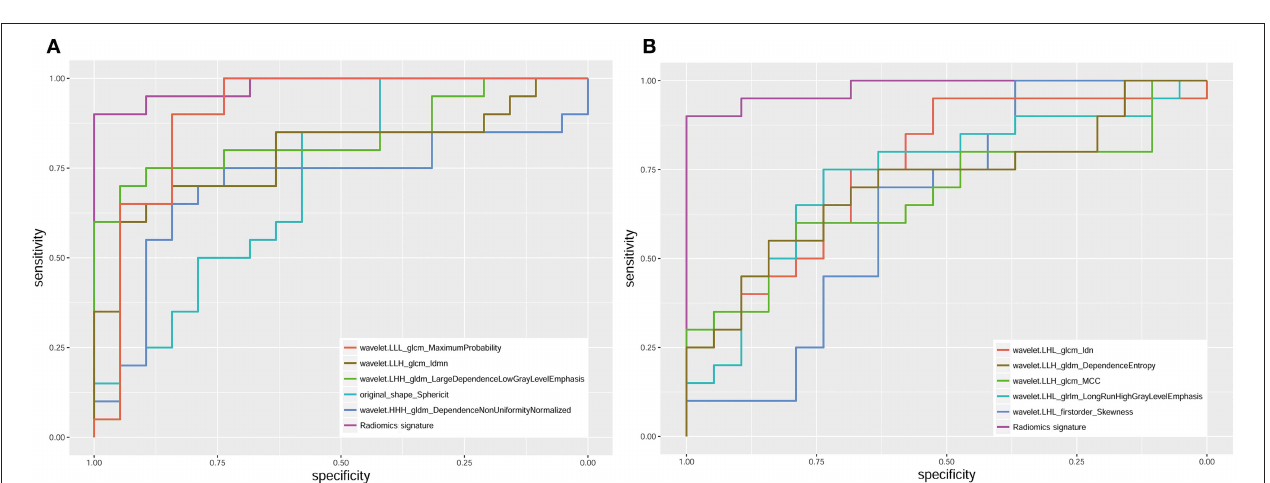
FIGURE 5 | (A) The contribution of the features to the radiomics signature. The histogram shows the contribution of the five features with non-zero coefficients to the radiomics signature. The features that contributed to the radiomics signature are plotted on the y-axis, and their coefficients in the LASSO Cox analysis are plotted on the x-axis. (B) Bar charts of the radiomics signature for each patient. The red bars indicate the radiomics signature of seminomas, while the light green bars indicate the radiomics signature of non-seminomas.